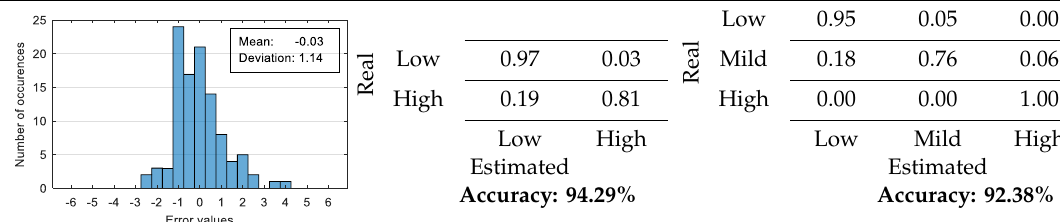
Table 11. Distribution of estimation errors and confusion matrices for levels 2 and 3 — using six features.